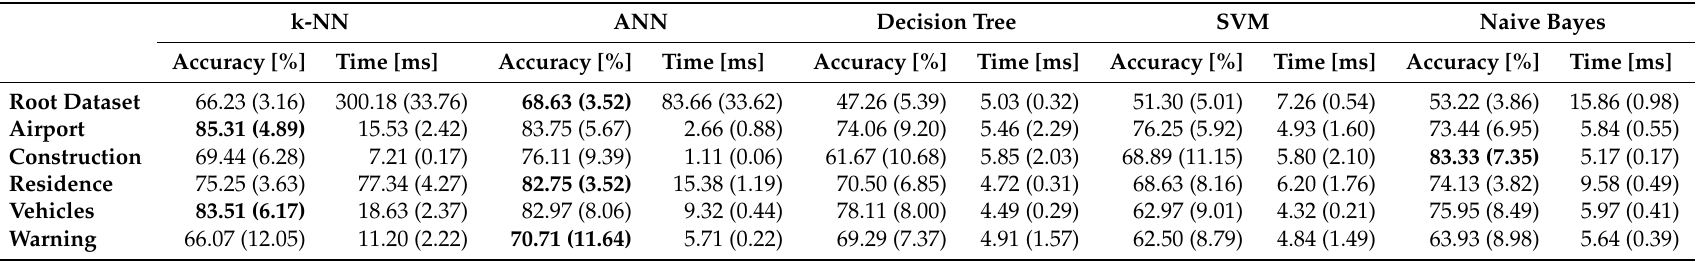
Table 15. Achievable accuracy and demanded execution time for the proposed cascade approach of the classifiers running on the Raspberry Pi. The most accurate classifier per dataset is marked in bold.